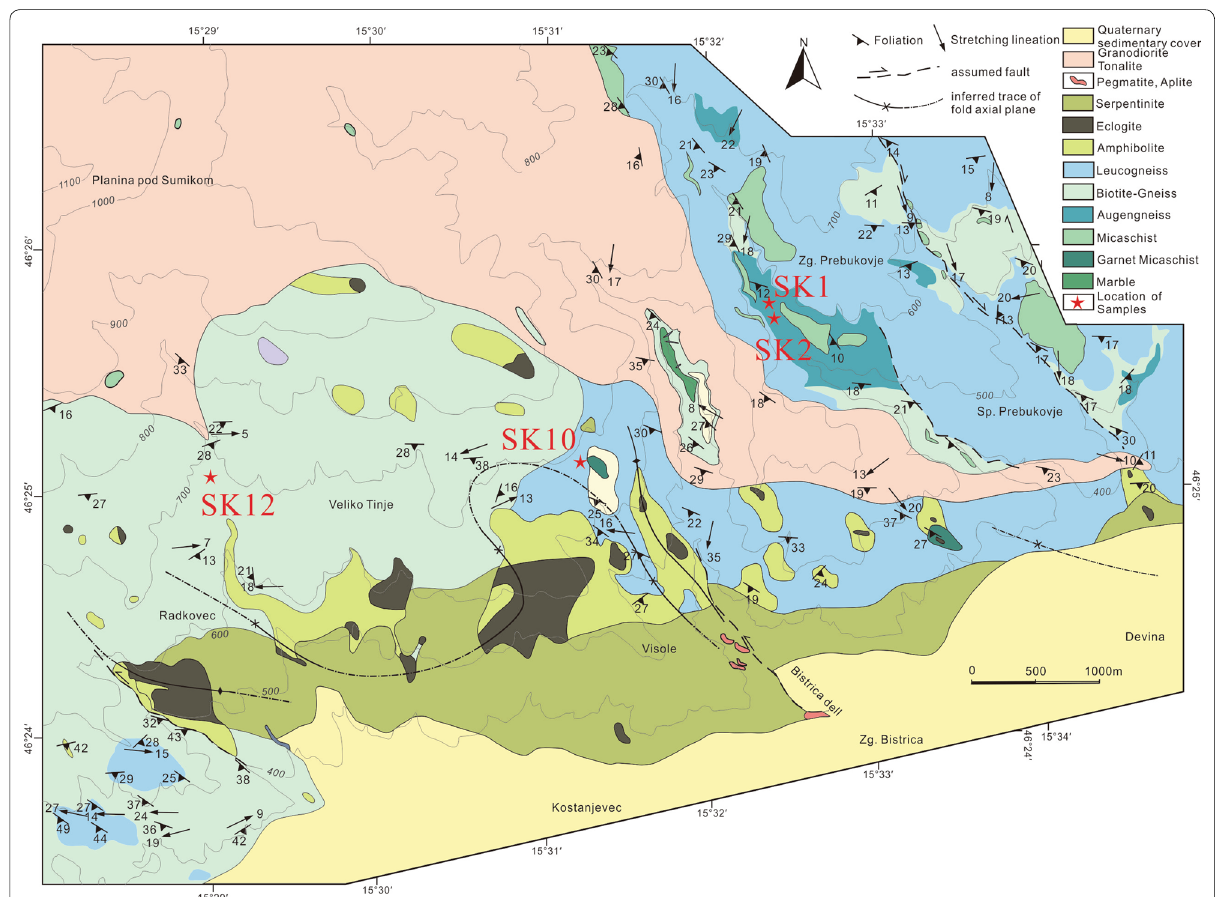
Fig. 3 Geological map of the study area NW of Slovenska Bistrica with sample locations (map modified after Kirst et al. 2010)